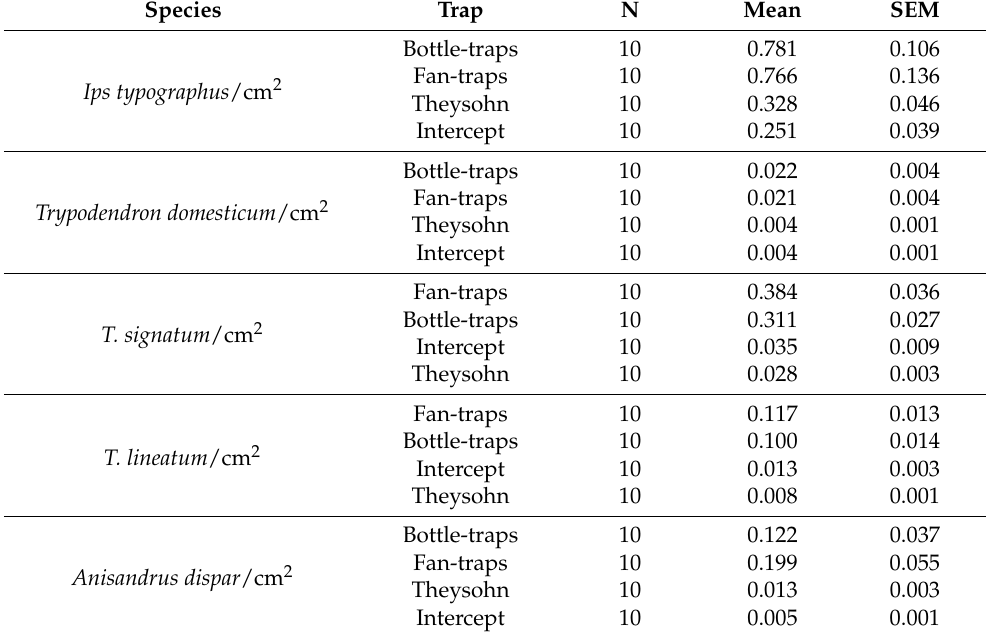
Table 2. Standardized total catches per trap (catches/cm 2 ) across the whole trapping period for each of the two groups of Scolytinae ( Ips typographus , and the “xylomycetophagous” species, i.e., Trypodendron lineatum , T. domesticum , T. signatum and X. dispar ). For each species, the traps are listed in decreasing order according to trapping results. Species Trap N Mean